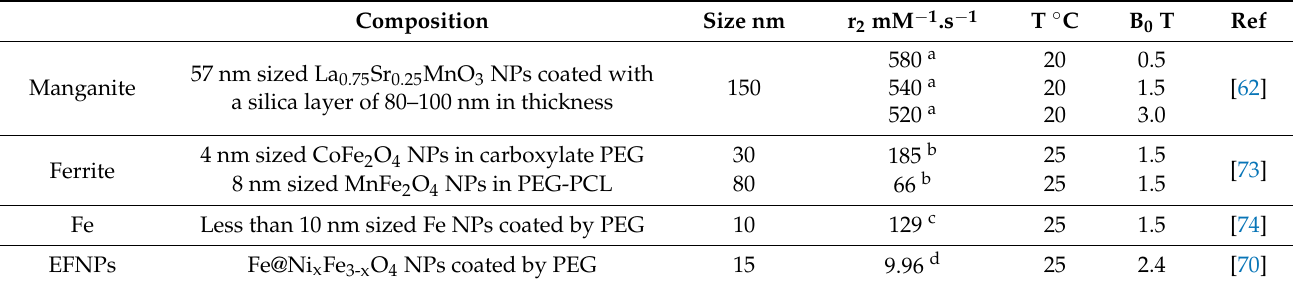
Table 4. Main characteristics of non-iron oxide negative